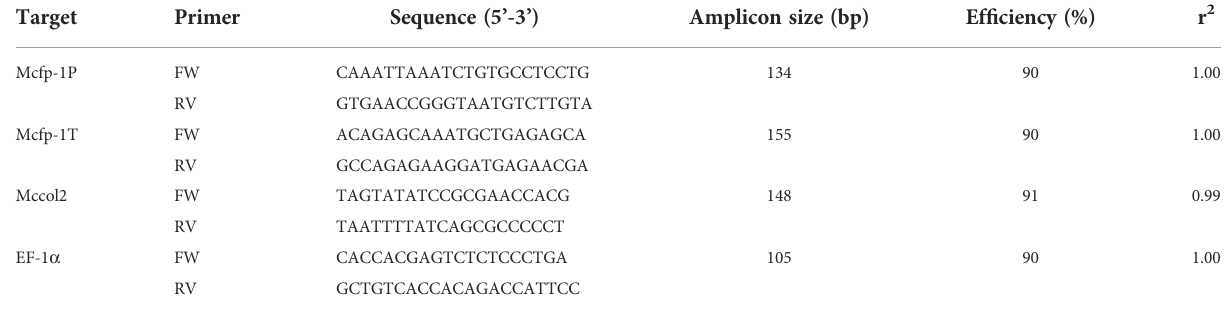
TABLE 1 Primers used to qRT-PCR expression analysis of 3 selected genes and EF-1 a .